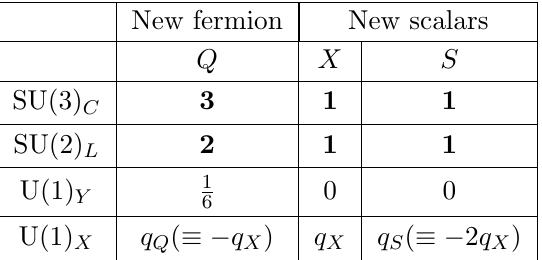
Table 1 . New particles in the model with their quantum numbers under the gauge group SU(3) C